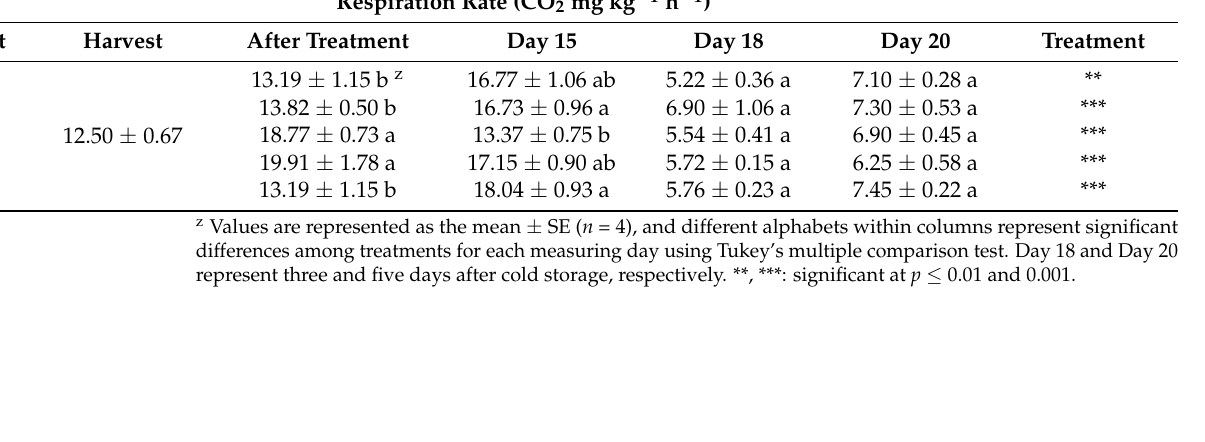
Table 1. Changes in respiration and ethylene production rates of sweet peppers pretreated with 10% CO 2 for 12, 24, and 48 h, as well as untreated and modified atmosphere packaging (MAP) with